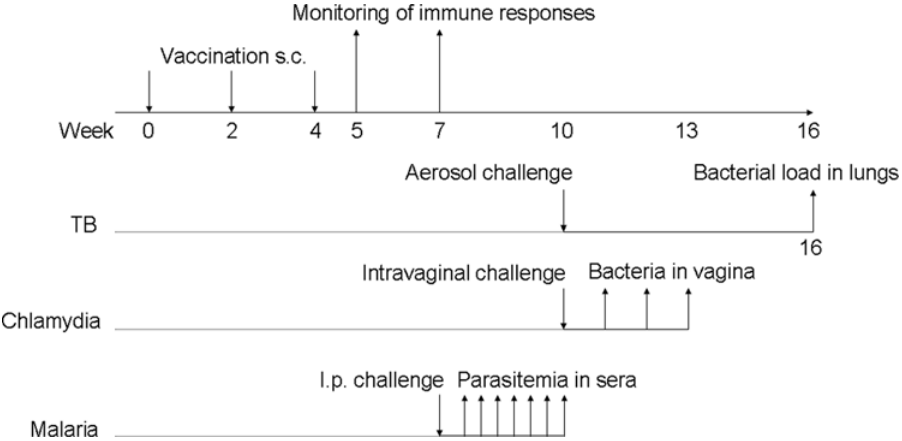
Figure 1. Time schedule for the immunization and infection regimen for TB, chlamydia and malaria.